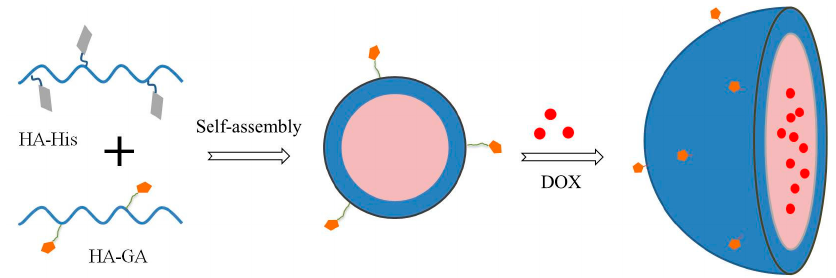
Figure 3. Preparation of HA–GA/HA–His mixed micelles.